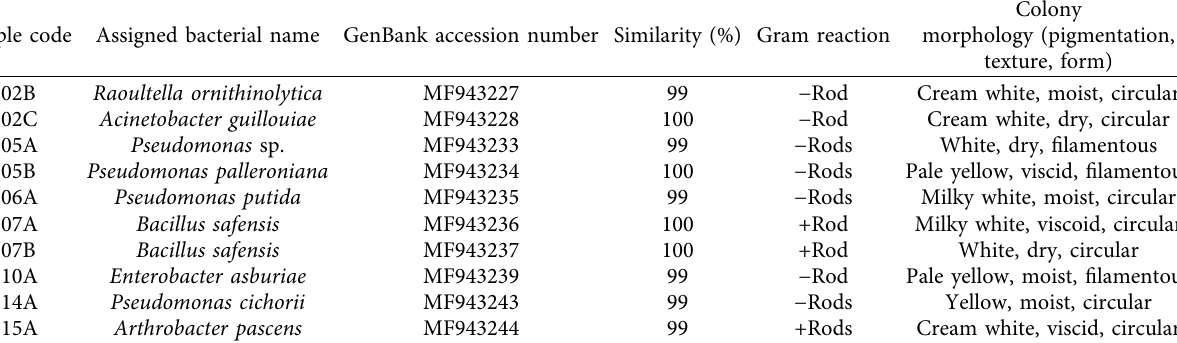
Table 1: Endophytic bacteria isolated from C. macowanii leaves. Sample code Assigned bacterial name GenBank accession number Similarity (%) Gram